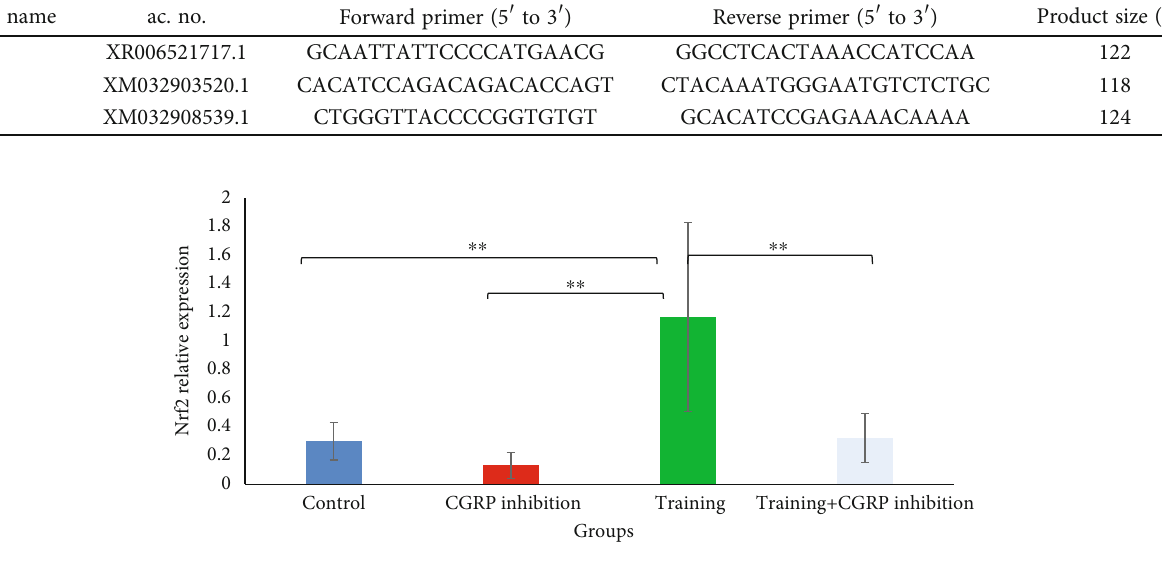
Figure 1: Nrf2 gene expression comparison in hippocampus between groups. ∗∗ Signi fi cant di ff erence compared to training group ( P < 0 : 05 ).